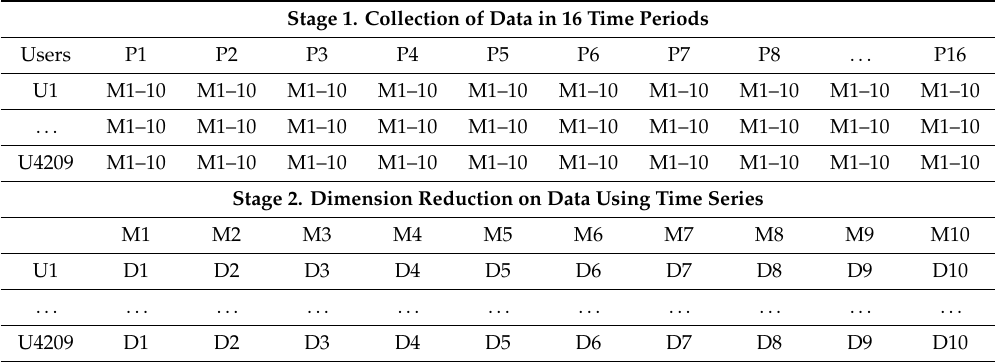
Table 3. The database formation stages of the data set (P: Period, U: User, and M: Metric). Stage 1. Collection of Data in 16 Time